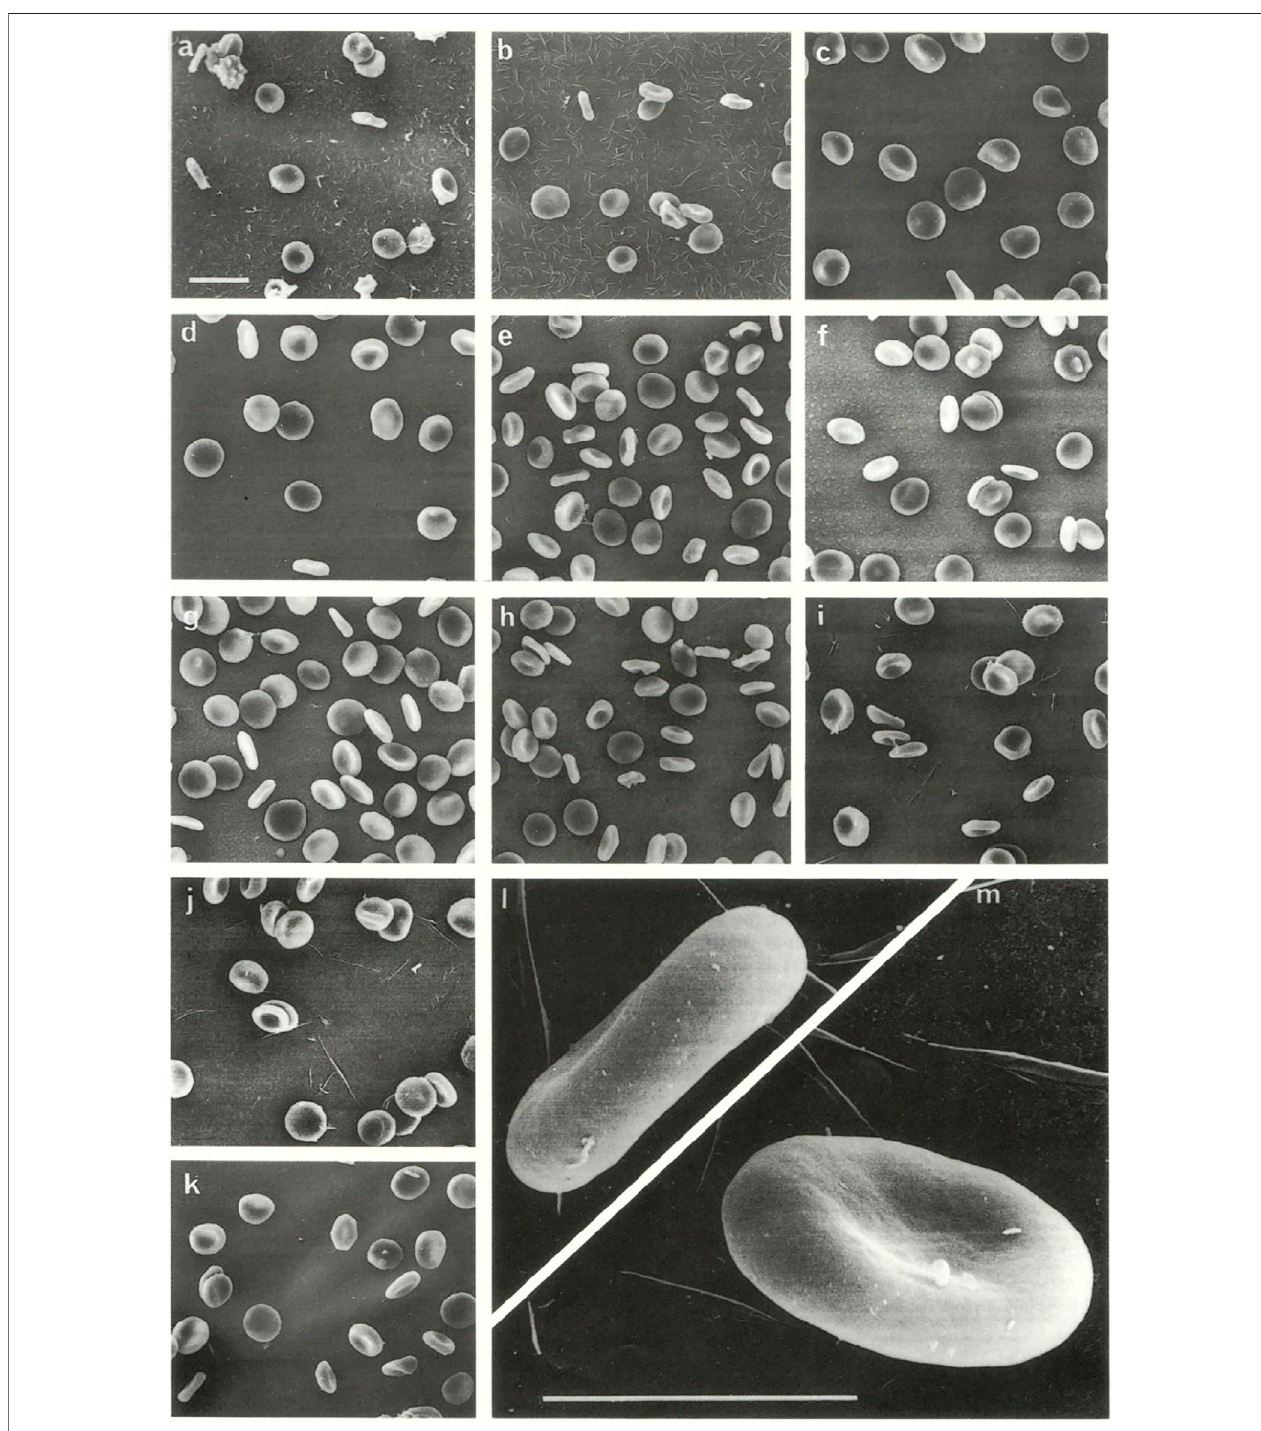
FIGURE 2 | Marsupials. Scanning electron microscopic appearance of red blood cells from (A) bandicoot; (B) bilby; (C) koala; (D) red kangaroo; (E) Bennett ’ s wallaby; (F) parma wallaby; (G) swamp wallaby; (H) Tammar wallaby; (I,J) whiptail wallaby; and (K – M) man. (A – K) original magni fi cation ×2,000, scale bar 5 µm; l, m original magni fi cation ×10,000, scale bar 5 µm. The original images were published by (Benga et al., 1992b).